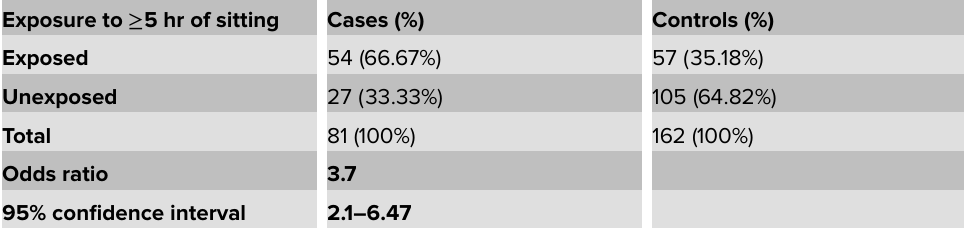
Table 3: Calculation of the odds